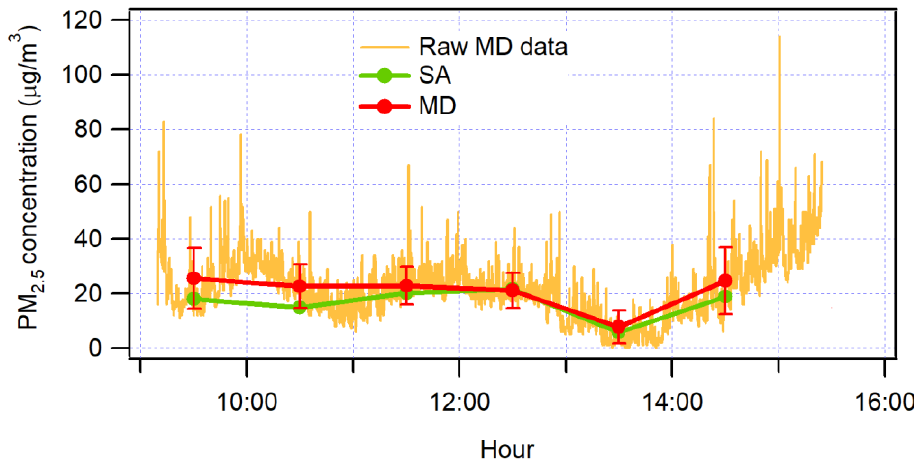
Figure 3. Raw Microdust (MD) Pro 10 s data (orange line), plotted against city air quality network Thermo Fisher Scientific BAM (SA) hourly data and hourly Microdust Pro data (MD).